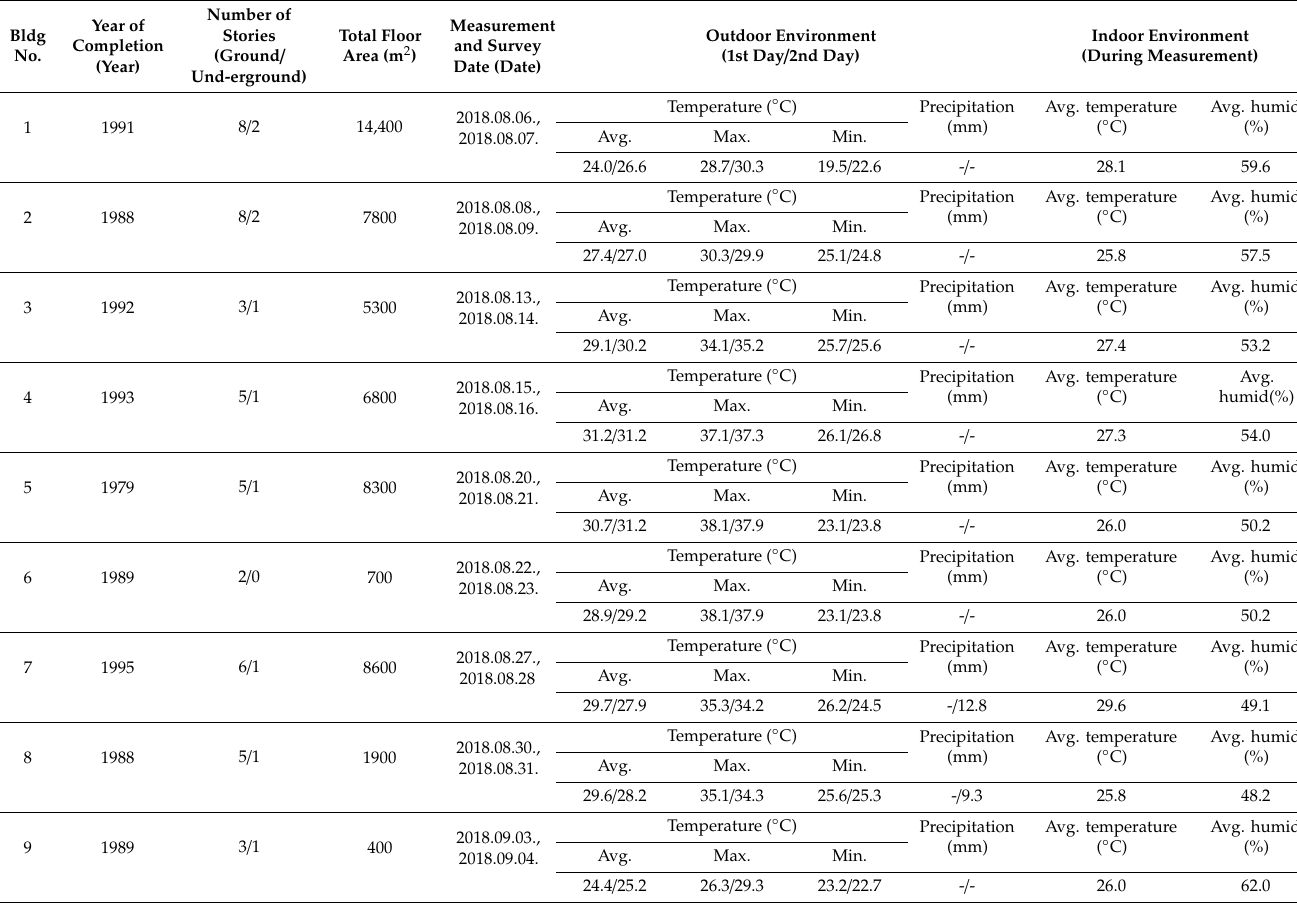
Table 2. Building information for measurement and